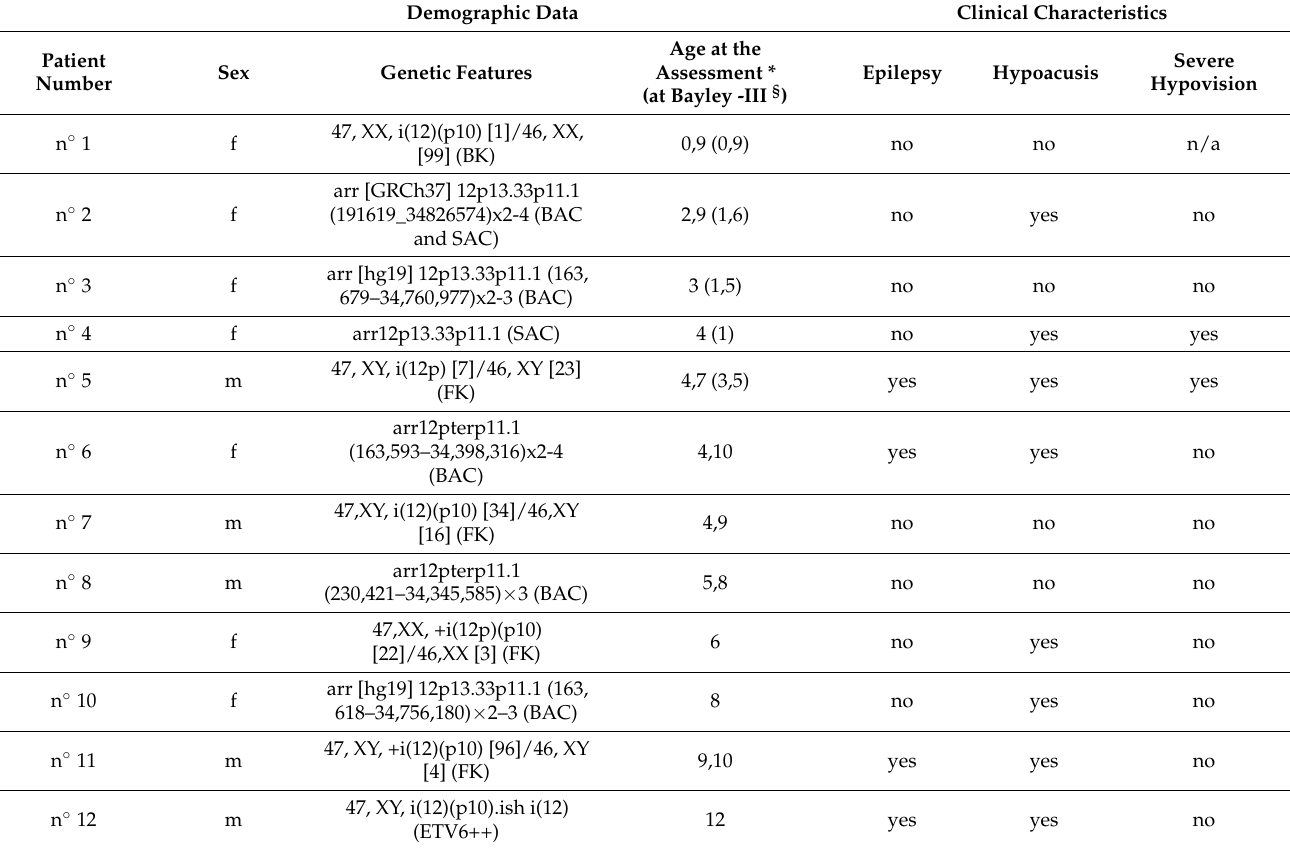
Table 1. Demographic and clinical characteristics of the